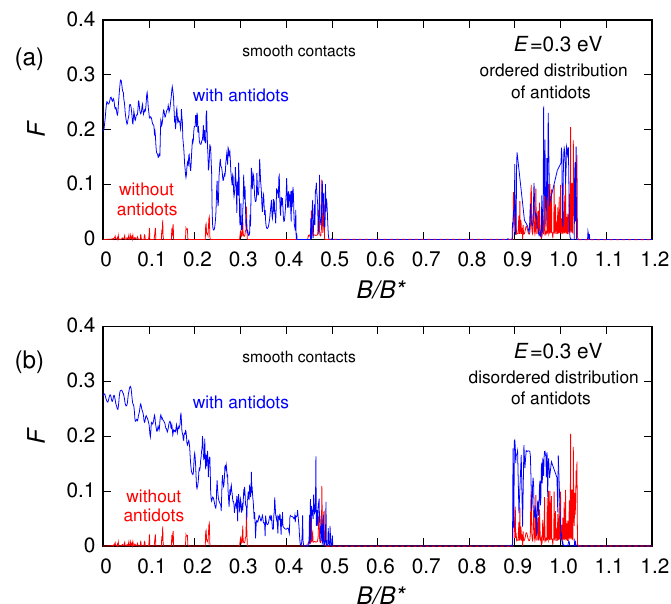
Figure 9. Fano factor of the graphene ribbon as a function of the orthogonal magnetic field (normalized with respect to B ∗ = 100 T), obtained for E = 0.3 eV in the presence of an ordered (panel ( a )) and a disordered (panel ( b )) distribution of antidots, compared with the Fano factor of the ribbon without